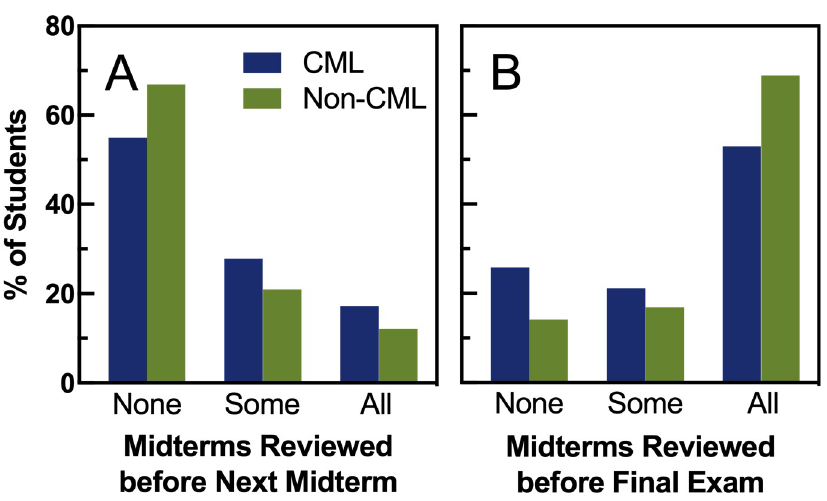
Fig 3. Effect of midterm type on timing of past exam review. In at attitudinal survey at the end of the semester, students self-reported the number (none, some, or all) of midterm exams that they reviewed prior to the next midterm exam (Panel A; Mann-Whitney U test, U = 12531.5, p = 0.037, n = 299), and in preparation for the final exam (Panel B; Mann-Whitney U test, U = 9241.5, p = 0.003, n = 299).